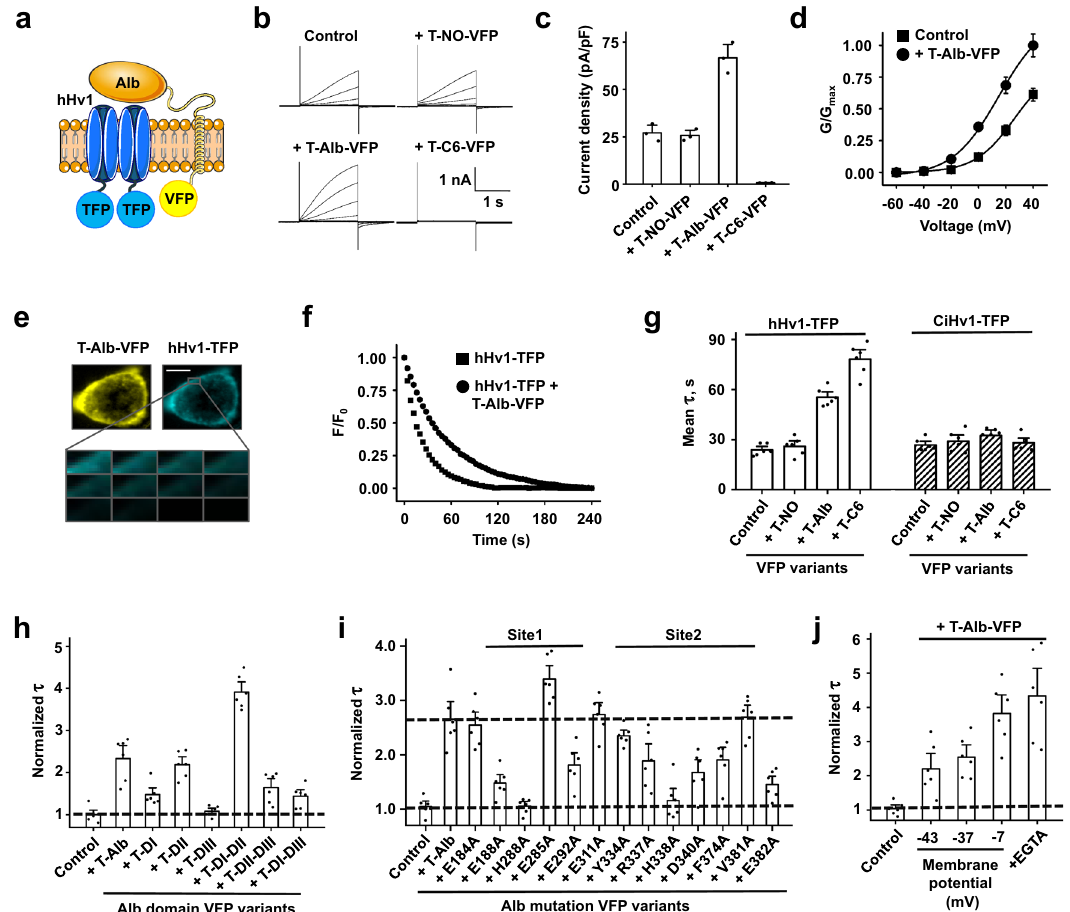
Fig. 5 DII of Alb is required for binding to hHv1 channels. Tethered constructs carrying VFP were expressed in HEK293T cells with channels tagged with TFP and studied by FRET microscopy. a Schematic representation of T-Alb-VFP showing binding of Alb to the hHv1-TFP channel. Extracellular interaction of Alb and hHv1 brought intracellular TFP and VFP into close proximity (<10 nm), resulting in FRET that was quanti fi ed by measuring the mean time constant ( τ ) for TFP (donor) photobleaching. b Representative current traces (20 mV steps from − 60 to + 40) for hHv1-TFP channels expressed alone (Control) or with T-Alb-VFP, T-NO-VFP (no Alb inserted), or T-C6-VFP. c Whole-cell peak current densities of hHv1-TFP channels at 0 mV expressed alone (Control) or with T-NO-VFP, T-Alb-VFP, or T-C6-VFP studied as in ( b ), n = 3 cells. d G-V relationships for hHv1-TFP expressed alone (black squares) or with T-Alb- VFP (black circles). Curves are fi t to a Boltzmann equation, n = 3 cells. e hHv1-TFP (cyan) and T-Alb-VFP (yellow) are shown to reach the cell surface. Scale bar is 10 μ m. The boxed area of membrane shows donor photobleaching with continuous illumination. f Exemplar photobleaching showing the decay of fl uorescence for regions of single cells expressing hHv1-TFP (black squares) or hHv1-TFP with T-Alb-VFP (black circles). τ was determined by single- exponential fi ts to the time course of photobleaching. g FRET showing hHv1-TFP (white bars) assembly with T-Alb-VFP or T-C6-VFP but not T-NO-VFP. CiHv1-TFP (white bars with black slash) 5 , did not show FRET with T-Alb-VFP or T-C6-VFP, n = 6 cells. h , Tethered Alb domain variants expressed with hHv1-TFP for FRET studies. τ of photobleaching for each pair was normalized to the τ of photobleaching of hHv1-TFP alone (Control). n = 6 cells. i T-Alb- VFP point mutations designed based on the two predicted interaction sites (Supplementary Fig. 13), expressed with hHv1-TFP for FRET studies. Control is hHv1-TFP expressed alone, n = 6 cells. j Adjusting KCl in the bath by isotonic substitution for NaCl from 2 mM to 10 mM and 100 mM changed the HEK293T cell RMP from − 43 ± 6 mV, to − 37 ± 4 mV and − 7 ± 2 mV, respectively. Increased binding of T-Alb-VFP and hHv1-TFP with membrane depolarization as demonstrated by the increasing τ , from 52 ± 7 s to 60 ± 7 s and 90 ± 11 s. When 1 mM EGTA was added to the solution with 10 mM KCl τ was further increased to 101 ± 15 s. Control is hHv1-TFP expressed alone with 10 mM KCl, n = 6 cells. Values are mean ± SEM. Source data are provided in the Source Data fi